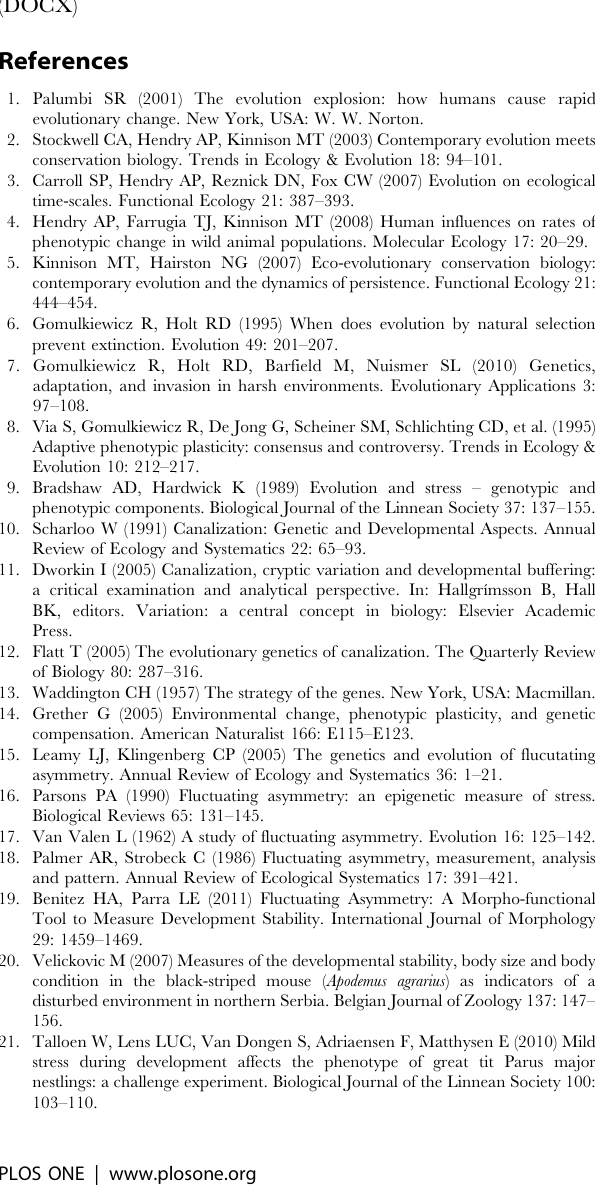
Table S6 Analysis of variance table for linear regres- sion fit to (a) ln (CFA) , and (b) Haldanes. The interaction between year (or generation ) and country was retained despite not being